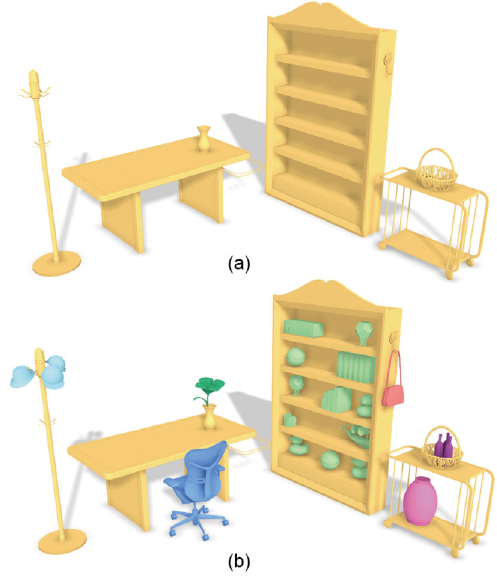
Fig. 7 Given a scene with furniture (a), each piece of furniture is adorned with objects (b) by localizing and completing possible interactions with it. Reproduced with permission from Ref. [96], c (cid:2) Institute of Electrical and Electronics Engineers